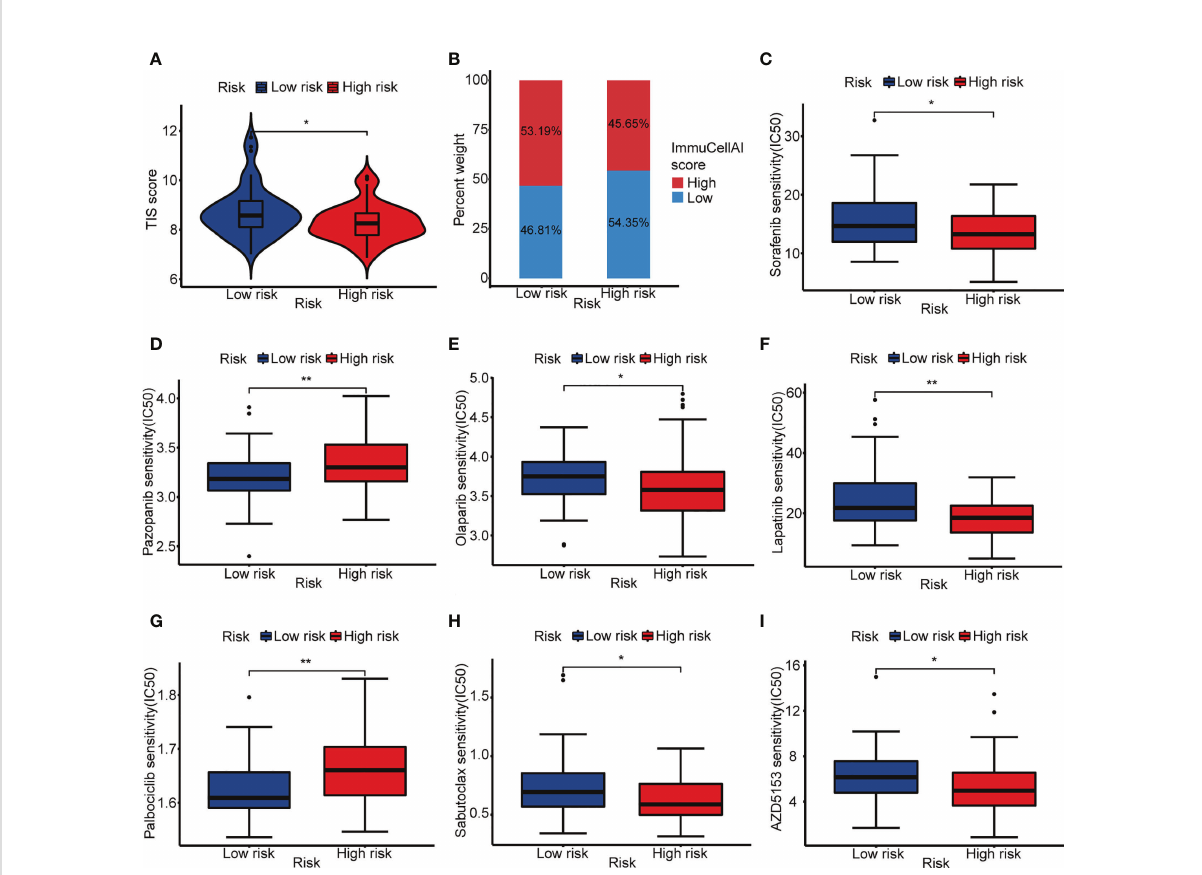
FIGURE 6 Immunotherapy response prediction and drug sensitivity. (A) ITS score of the low- and high-risk groups. (B) Proportion of high and low ImmuCellAI score in the low- and high-risk groups. (C – I) IC 50 of sorafenib, pazopanib, olaparib, lapatinib, palbociclib, sabutoclax, and AZD5153 in the low- and high-risk groups. (* p < 0.05, ** p <